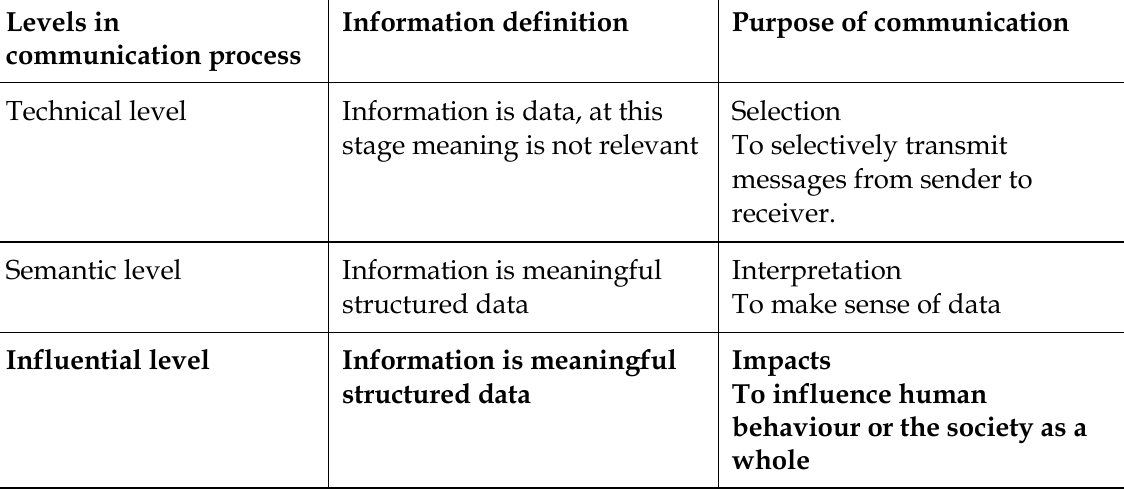
Levels in communication process